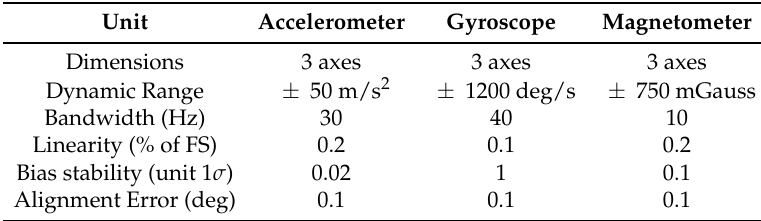
Figure 1. The principle and structure of the proposed gait analysis system ( a ) self-made motion tracking sensor nodes; ( b ) gait analysis scenario. Table 3. Sensor performance